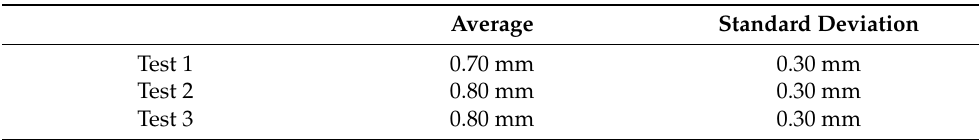
Table 5. Average and standard deviation between CAD and computed trajectory for V-type butt joint.